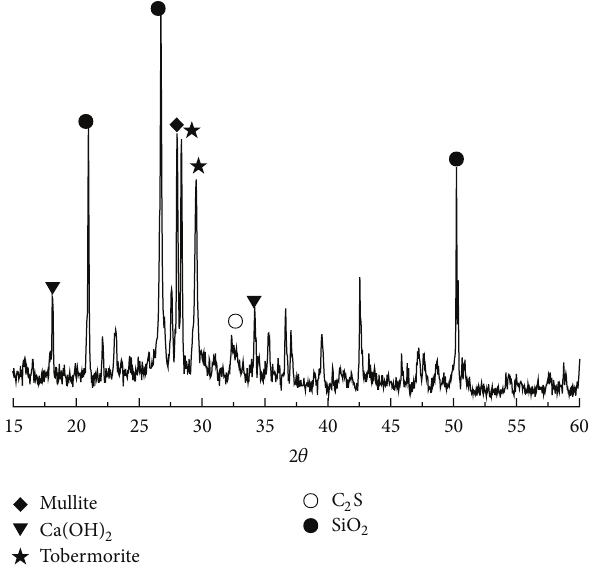
Figure 1: XRD pattern of GWC powder.